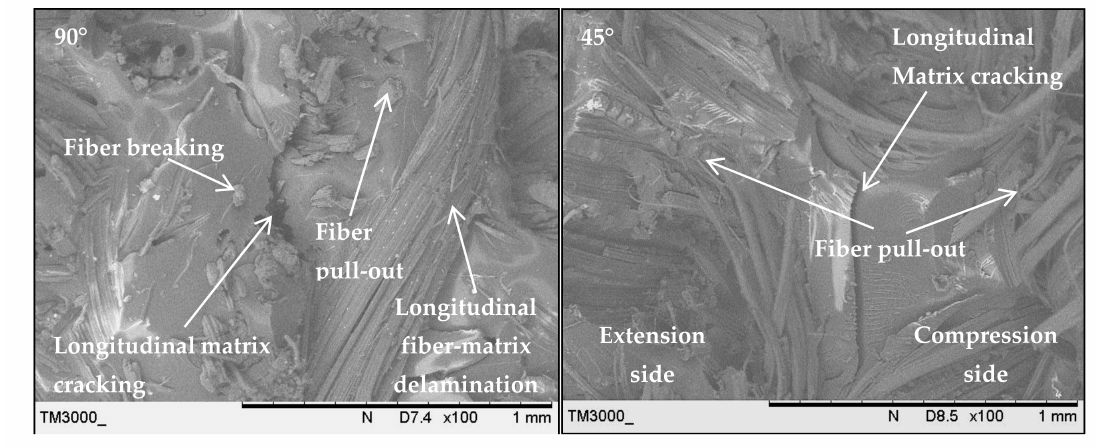
Figure 13. Scanning electron microscopy images of the treated PALF laminate (PPPP-treated) with ply orientations [0 ◦ , 90 ◦ ] and [ ± 45 ◦